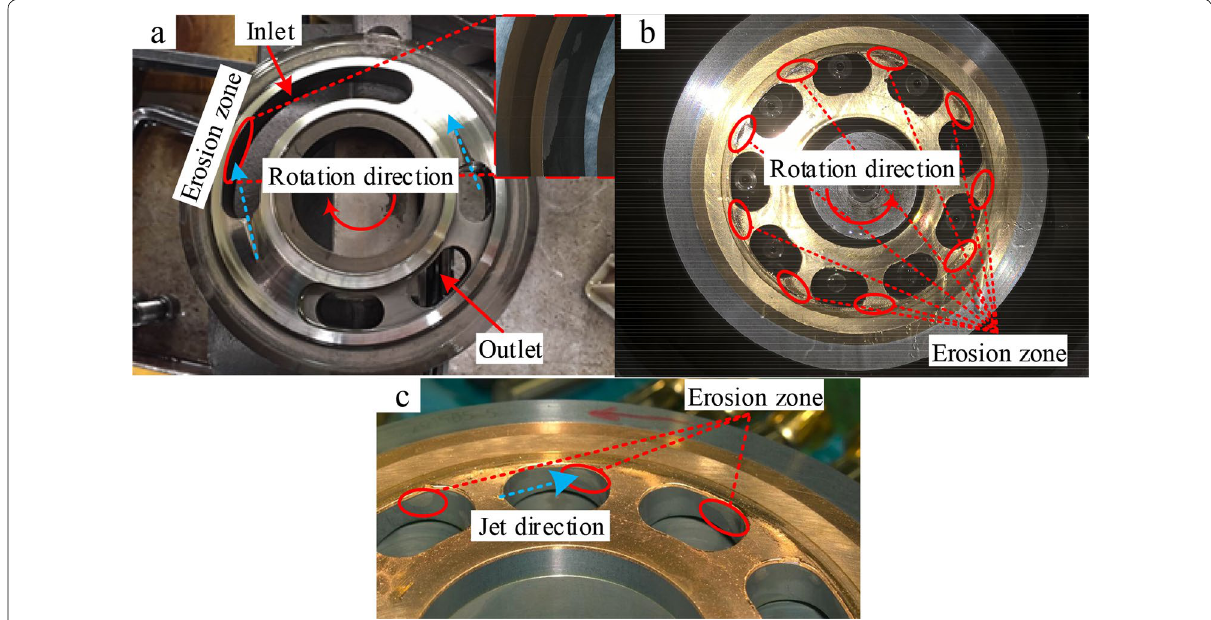
Figure 15 Experimental cavitation photos of the spherical interface: a Cavitation damage map on the upper end of the valve plate, b Cavitation damage on the lower surface of the cylinder block, c Cavitation damage on the sidewall surface of the kidney trough of cylinder